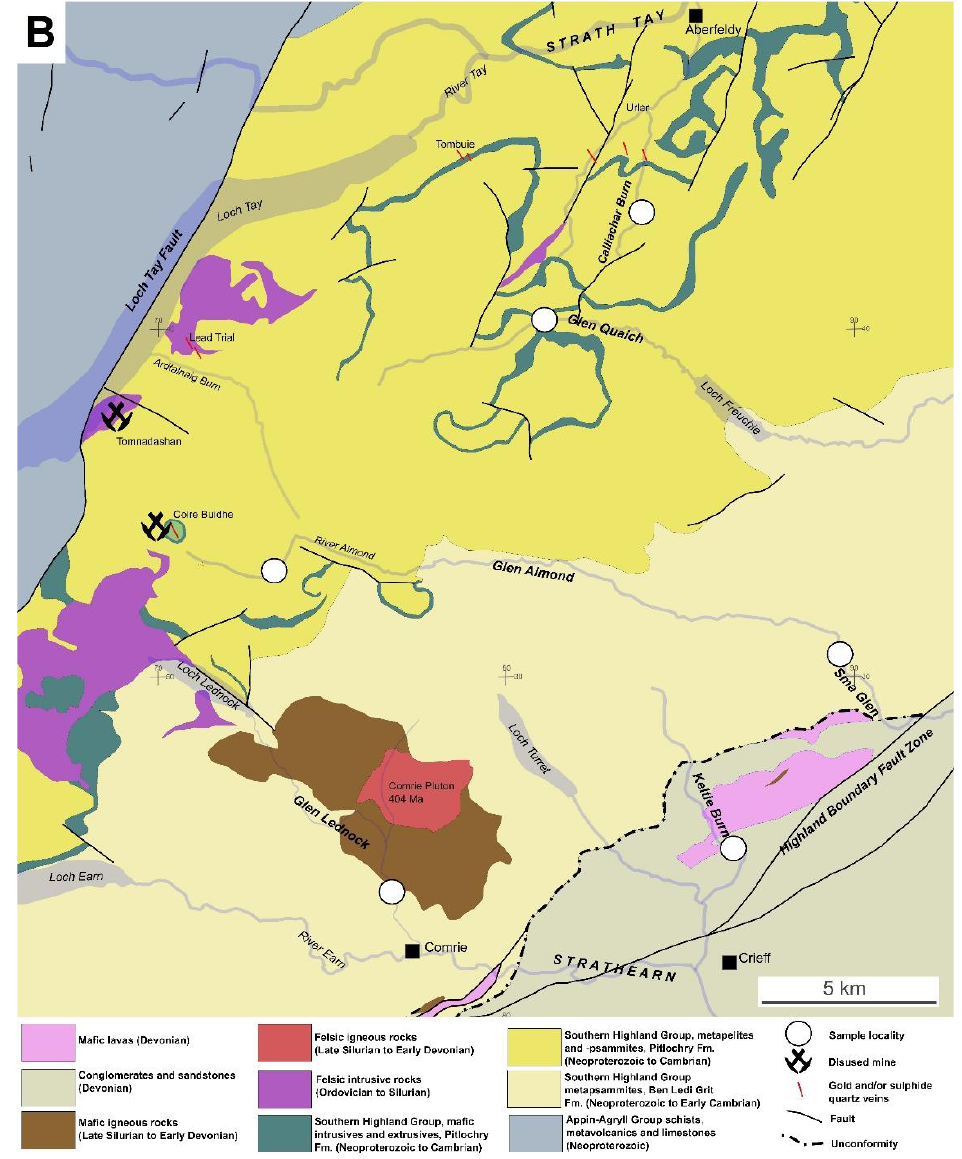
Figure 1. ( A ) Simplified geological map of central Scotland. The location of the study area is indicated with a red rectangle (Figure 1B overleaf); the area of the Ochil Hills gold particle study area of Chapman et al. (2005) [33] is indicated by a white box. The Early Devonian Rhynie gold occurrence is also indicated. ( B ) Geological map of the study area. The sampling localities are indicated, along with the location of the known gold- and sulphide-bearing quartz vein systems.